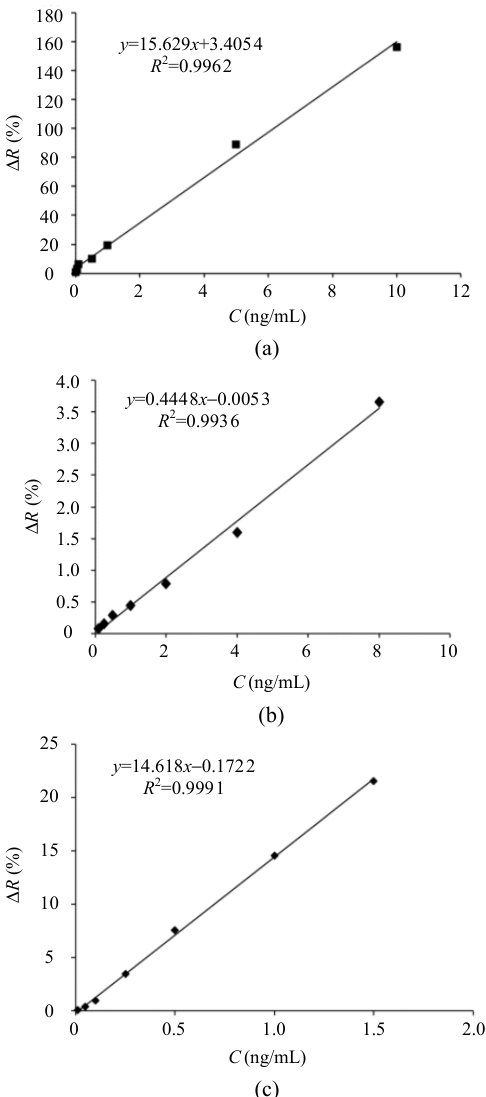
Fig. 7 Standard calibration curves [(a) vitamin B2 imprinted SPR sensor, (b) vitamin B9 imprinted SPR sensor, and (c) vitamin B12 imprinted SPR